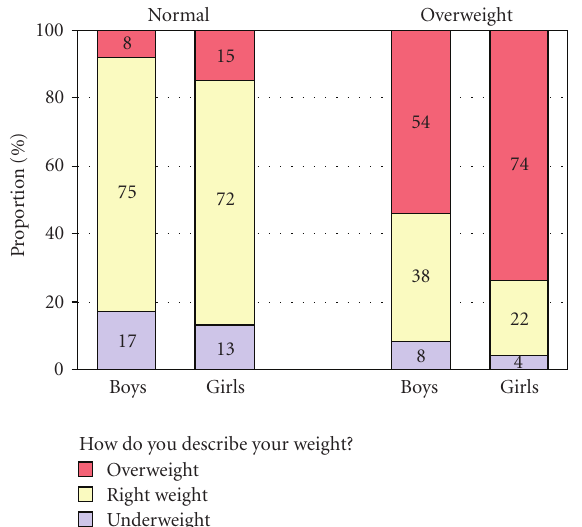
Figure 2: Narrative description of self-perceived weight according to sex and actual weight status.